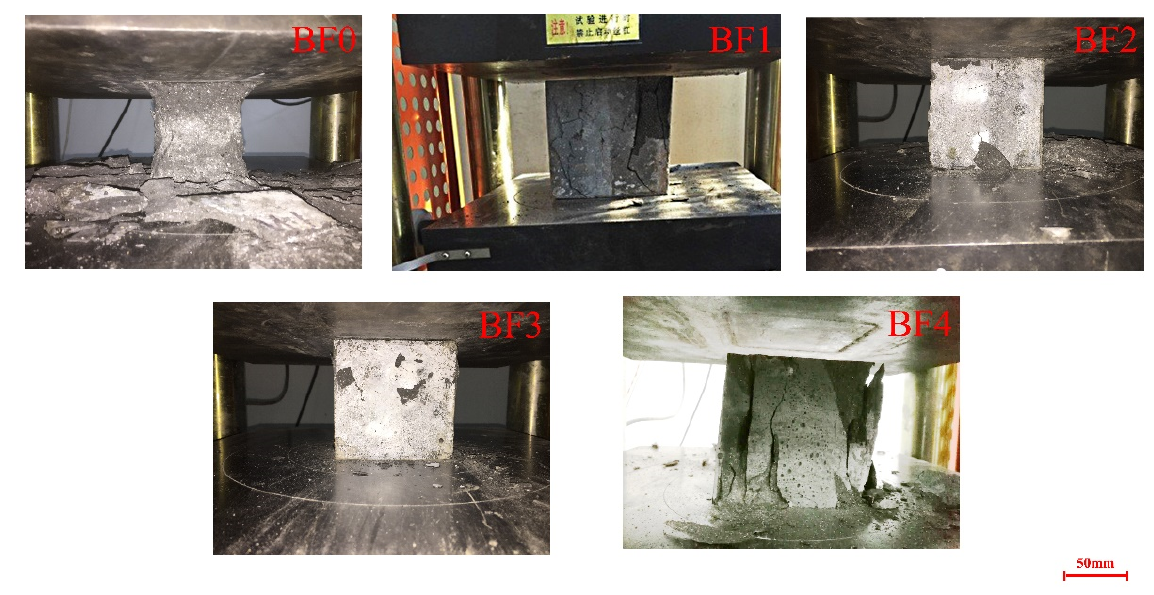
Figure 6. Compressive strength failure mode.